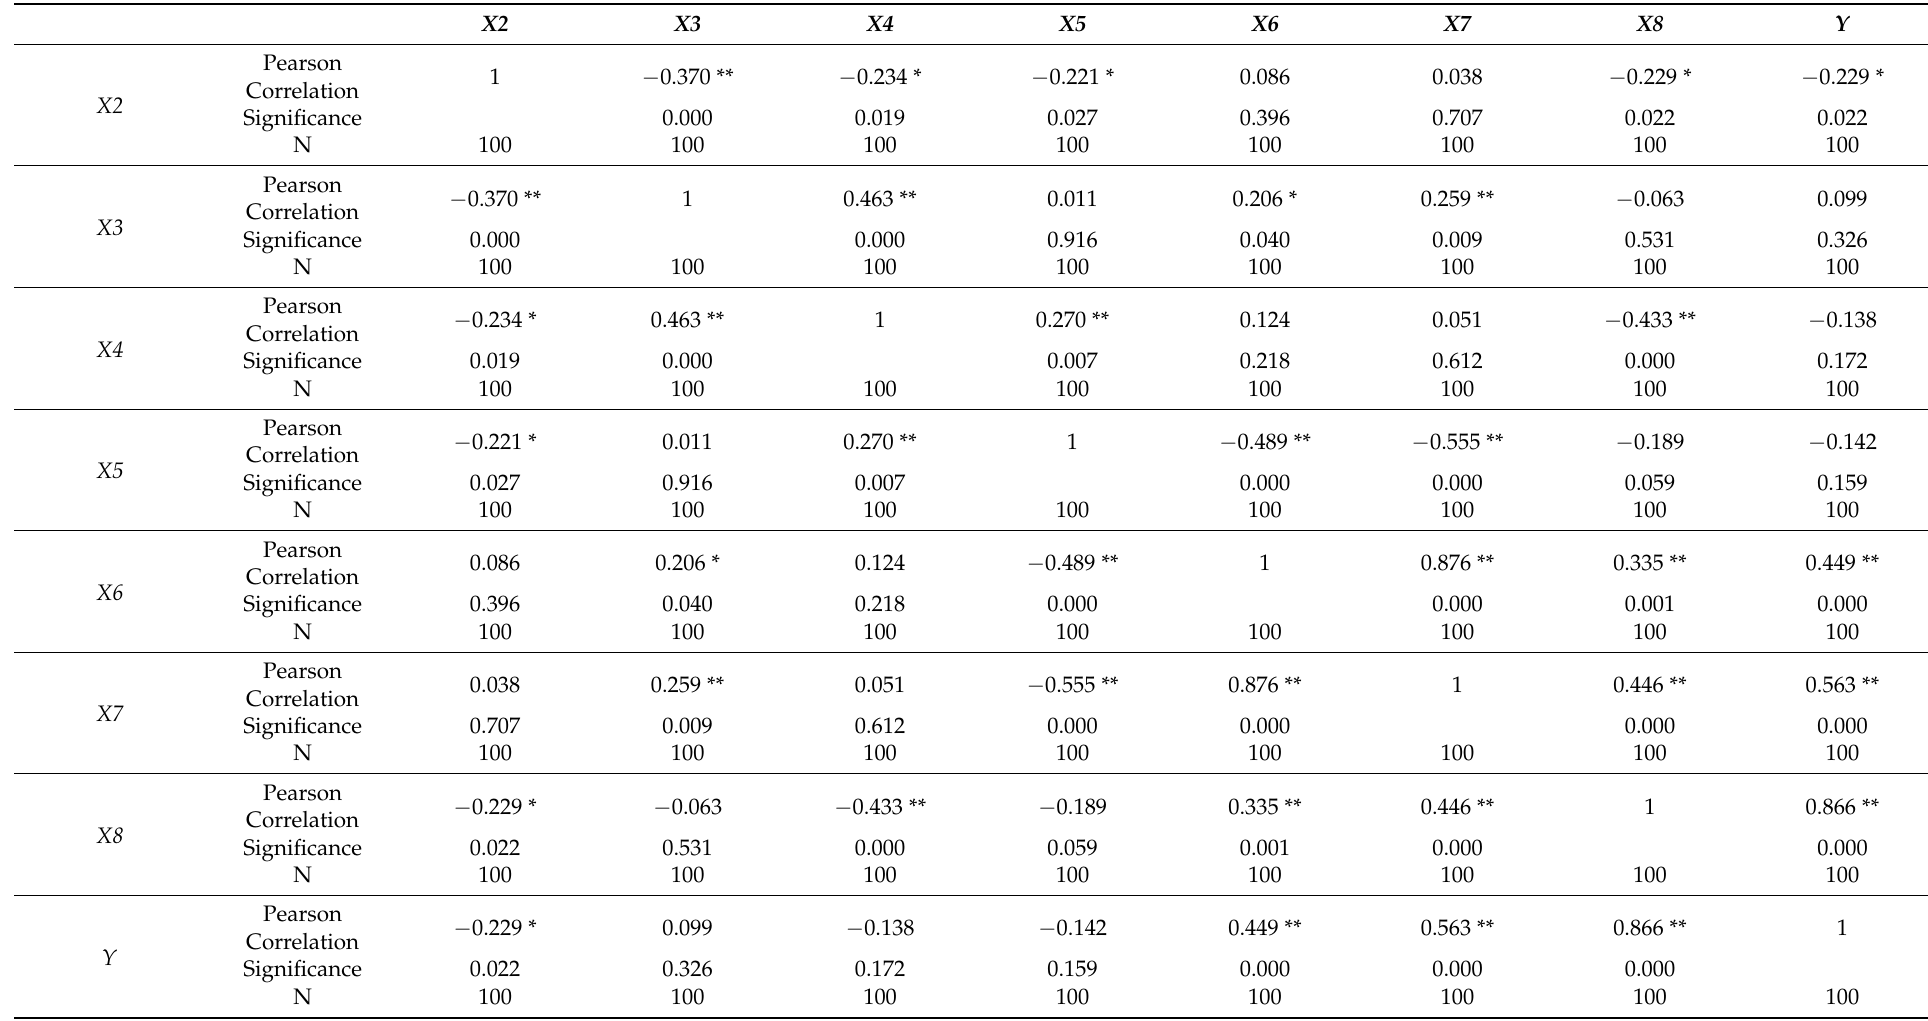
Table 5. Matrix of the correlation between the geotechnical parameters (**: Correlation is significant at the 0.01 level; *: Correlation is significant at the 0.05